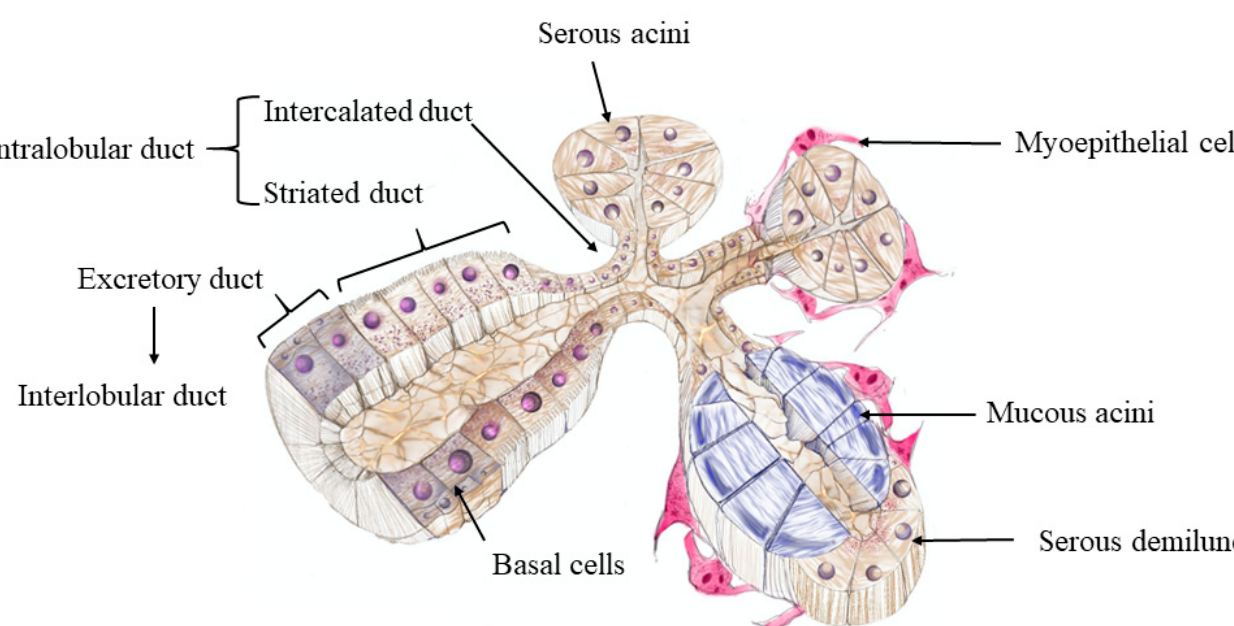
Figure 1. Schematic representation of the histology of salivary glands. Reprinted from [5,6] with permission. Ducto-acinar architecture of salivary glands is divided by capsular connective tissue septa into lobules. Each lobule consists of numerous serous/mucous/mixed (also known as serous demilune around mucous acini) secretory acini that are enveloped by myoepithelial cells. The secretory acini unite to form intercalated ducts (lined by simple squamous to low cuboidal epithelium and wrapped by myoepithelial cells). Saliva is secreted by acinar cells and drains into the striated ducts that are lined by simple or pseudostratified columnar epithelial cells. This ductal lining transforms into stratified squamous epithelium supported by basal cells. Ultimately, the striated ducts drain into the excretory ducts (also known as interlobular ducts) with tall columnar epithelial cells. Figure adapted from Tran et al., 2019 and Proctor and Shaalan, 2018 [5,6].